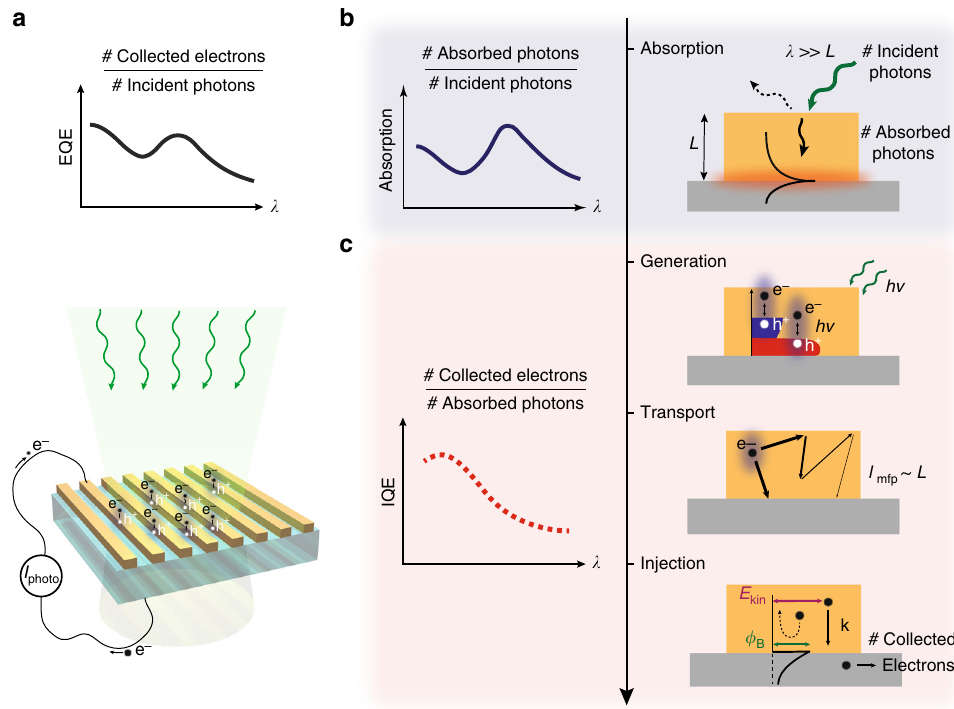
Fig. 1 Carrier generation and transport in photoexcited metal nanostructures. a Schematic representation of carrier generation and transport via internal photoemission (IPE) in a plasmonic metal – semiconductor heterostructure: charge carriers created in the metal upon illumination are separated across the metal – semiconductor interface generating a photocurrent at sub-bandgap photon energies. The external quantum ef fi ciency (EQE) spectrum